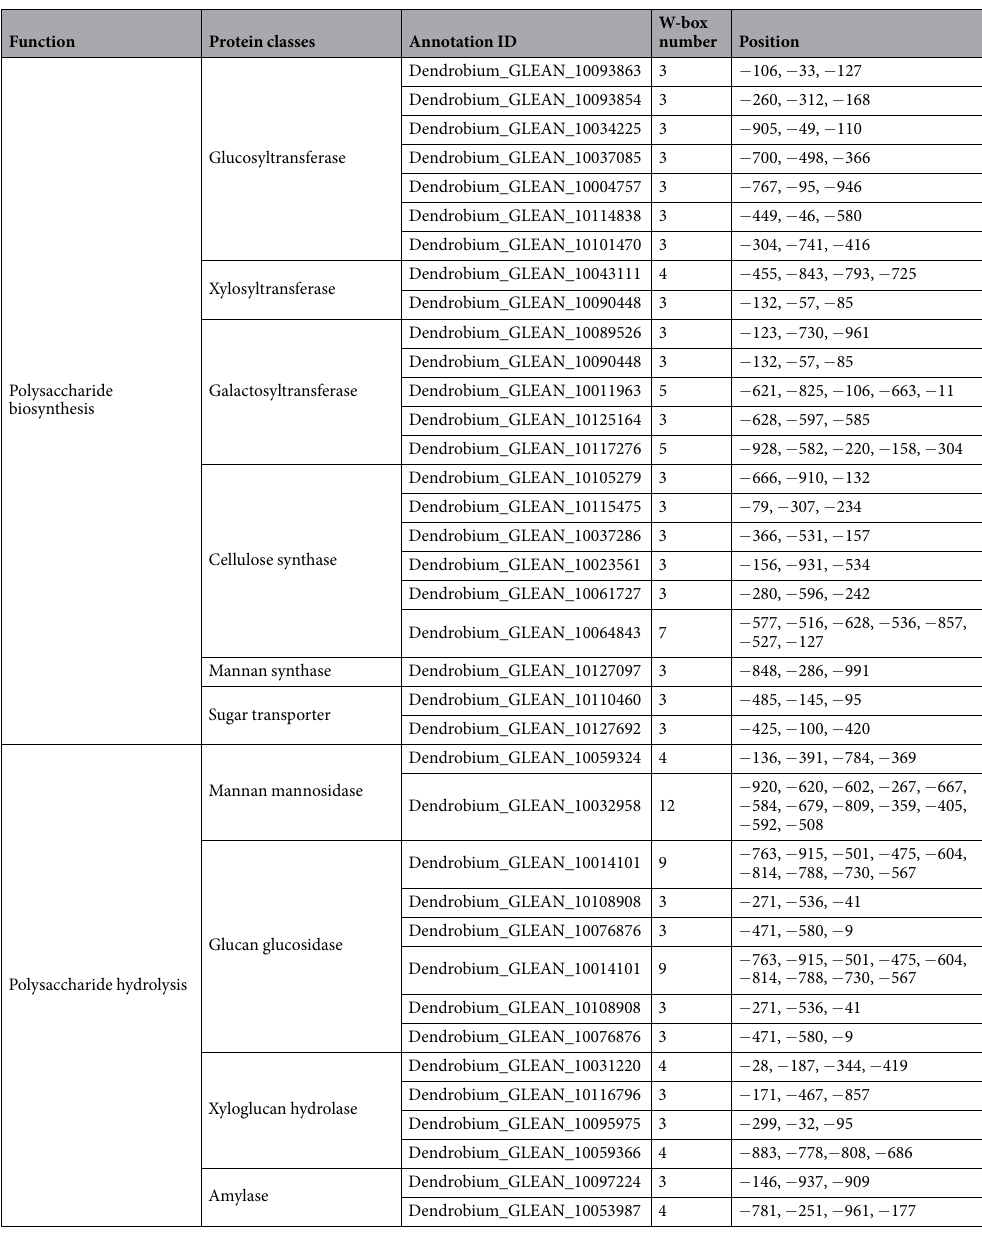
Table 2. Identified polysaccharide metabolism-related genes from WRKY target genes and their related a weaker stem with fewer sclerenchyma cells and vascular bundles, and thinner stems 66 . The WRKY13 protein can bind to the NST2 genes’ promoter, which belongs to the NAC family that regulates secondary wall biosynthesis 66 . The mutants of WRKY TFs from Medicago truncatula and A. thaliana can cause secondary wall thickening in pith and are negative regulators of secondary wall formation 67 . A recent study showed that PtrWRKY19 , a homolog of A. thaliana WRKY12 in Populus trichocarpa , encoded a protein located in the nucleus and functioned as a transcriptional repressor of lignin biosynthesis-related genes 68 . Thus, WRKY TFs might function as negative regulators of carbohydrate metabolism. In conclusion, a total of 63 WRKY genes were identified from an orchid plant, D . officinale . The classification and conserved domain of DoWRKY proteins, as well as stress-responsive elements in the promoters of DoWRKY genes were analyzed. Seventeen of the 63 DoWKRY genes were inducible by cold stress, indicating that they may play a role in the cold stress response of D . officinale . The WRKY target genes were investigated. Multiple W-box elements were observed in the promoters of stress-related genes and in genes related to polysaccharide metab- olism, suggesting that DoWRKY genes may be involved in the regulation of abiotic stress response as well as in polysaccharide metabolism.